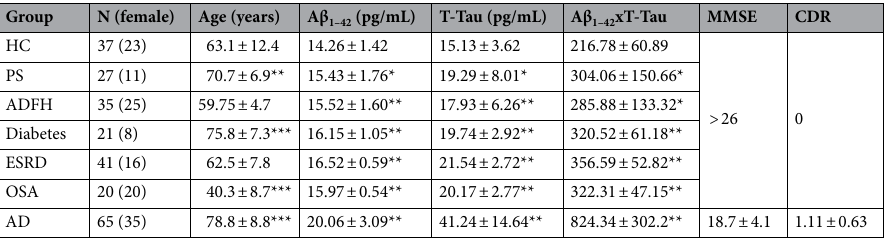
Table 2. Numbers, age, and measured plasma biomarker levels of enrolled subjects. HC healthy control, PS poststroke, ADFH family history of Alzheimer’s disease, ESRD end-stage renal disease, OSA obstructive sleep apnea, AD Alzheimer’s disease, Aβ amyloid β, T-Tau total tau protein. * p < 0.05 with respect to HC; ** p < 0.01 with respect to HC; *** p < 0.001 with respect to